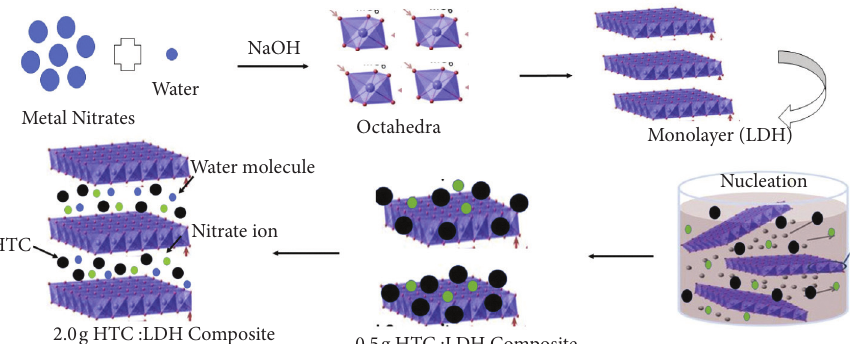
Figure 6: Pictorial representation of synthesized